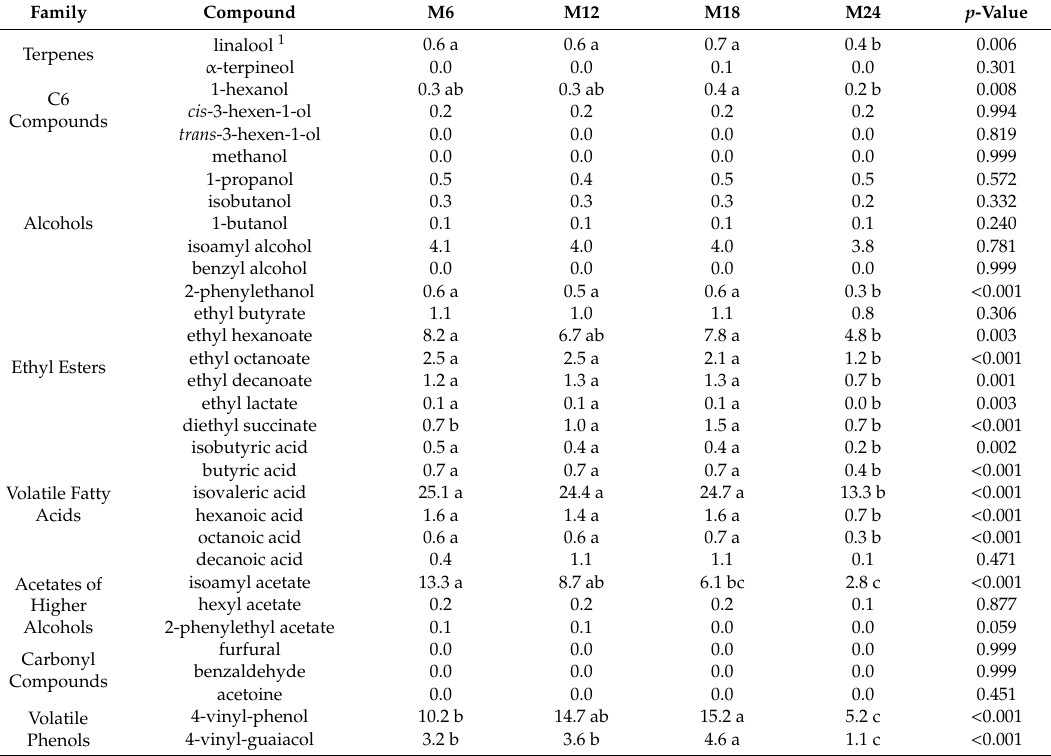
Table 3. Odor activity values of volatile compounds in Treixadura wines from the Ribeiro DO at di ff erent times of bottle aging. M6, M12, M18, and M24 indicate 6, 12, 18, and 24 months after